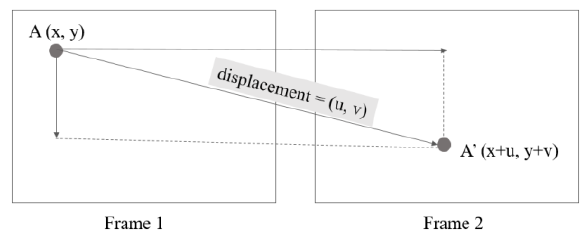
Figure 1. The illustration of the displacement’s